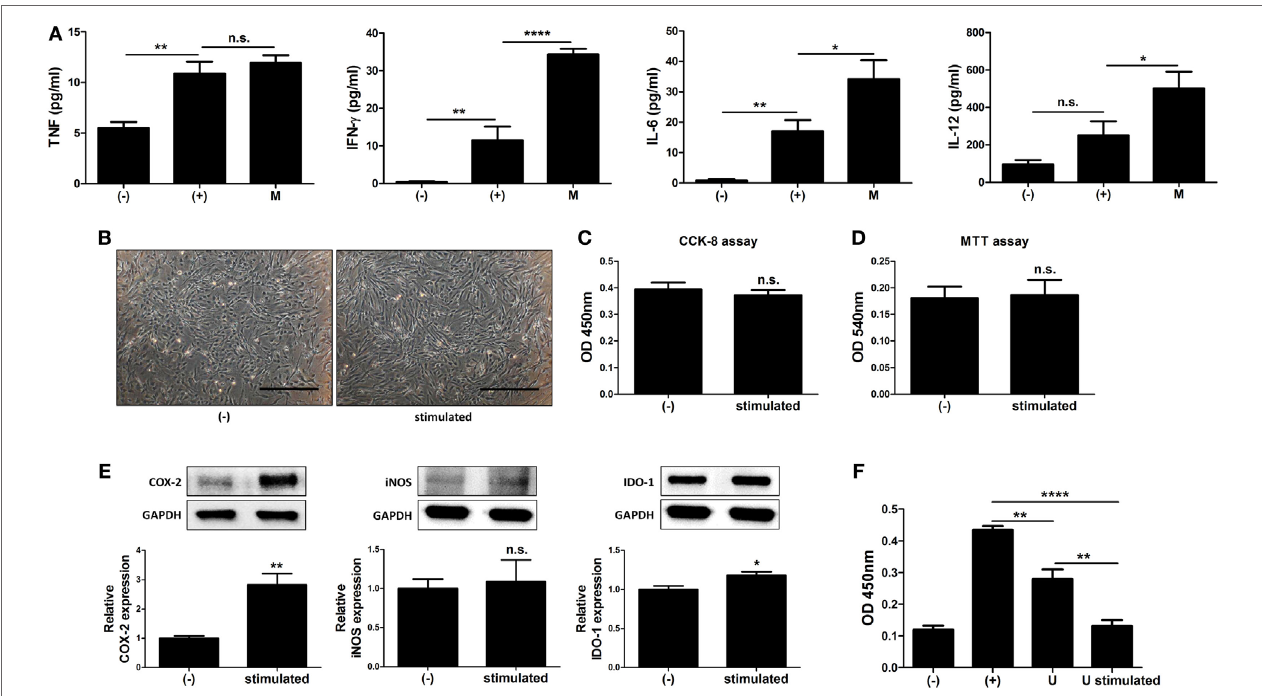
FigUre 6 | MIS416-mediated increase of cytokines upregulate immunomodulative function of human adult stem cells, including umbilical cord blood-derived mesenchymal stem cells (hUCB-MSCs). (a) The levels of tumor necrosis factor (TNF), interferon (IFN)- γ , IL-6, and IL-12 in serum of mice were evaluated a day after MIS416 administration (day 2) by CBA analysis. (B–F) Combination of cytokines, IL-6 (25 ng/ml), IL-12 (20 ng/ml), and IFN- γ (20 ng/ml), were used to treat hUCB-MSCs for 24 h. (B) Representative of bright-field microscopy images of hUCB-MSCs, bar = 500 µm. Proliferation and cell viability of hUCB-MSCs were determined by (c) CCK-8 assay and (D) MTT assay. (e) The expression levels of COX2, iNOS, and IDO-1 in hUCB-MSCs were analyzed using western blot analysis. (F) hUCB-MNCs were co-cultured with hUCB-MSCs stimulated with the cytokines directly and their proliferation was determined by bromodeoxyuridine ELISA assay. n = 7–8 mice per group, two independent animal experiments were performed. In vitro experiments were performed in triplicate. Gel electrophoresis was conducted under the same experimental conditions, and images of blots were cropped. Uncropped blot images are shown in Figure S7 in Supplementary Material. ( − ): negative control group, ( + ): DSS administered group in (a) and ConA activated group in (F) , M: MIS416-treated group, U: hUCB-MSCs, stimulated/U stimulated: cytokine cocktail-treated hUCB-MSCs. * P < 0.05, ** P < 0.01, **** P < 0.0001. Results are shown as the mean ±